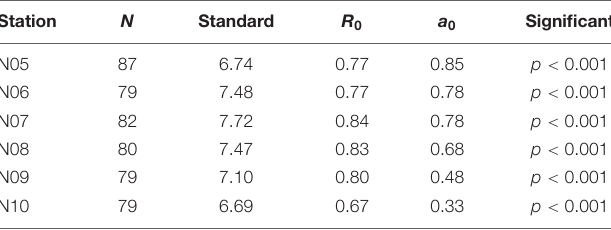
TABLE 4 | Correlation analysis between the steric height (relative to 800 m) and SSH. Station